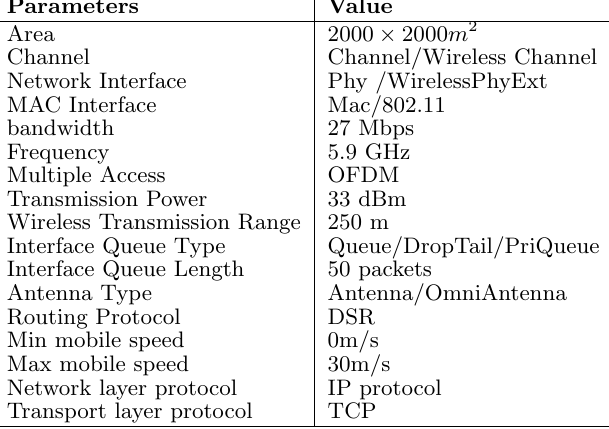
Table 1: Simulator Parameter Setting Parameters